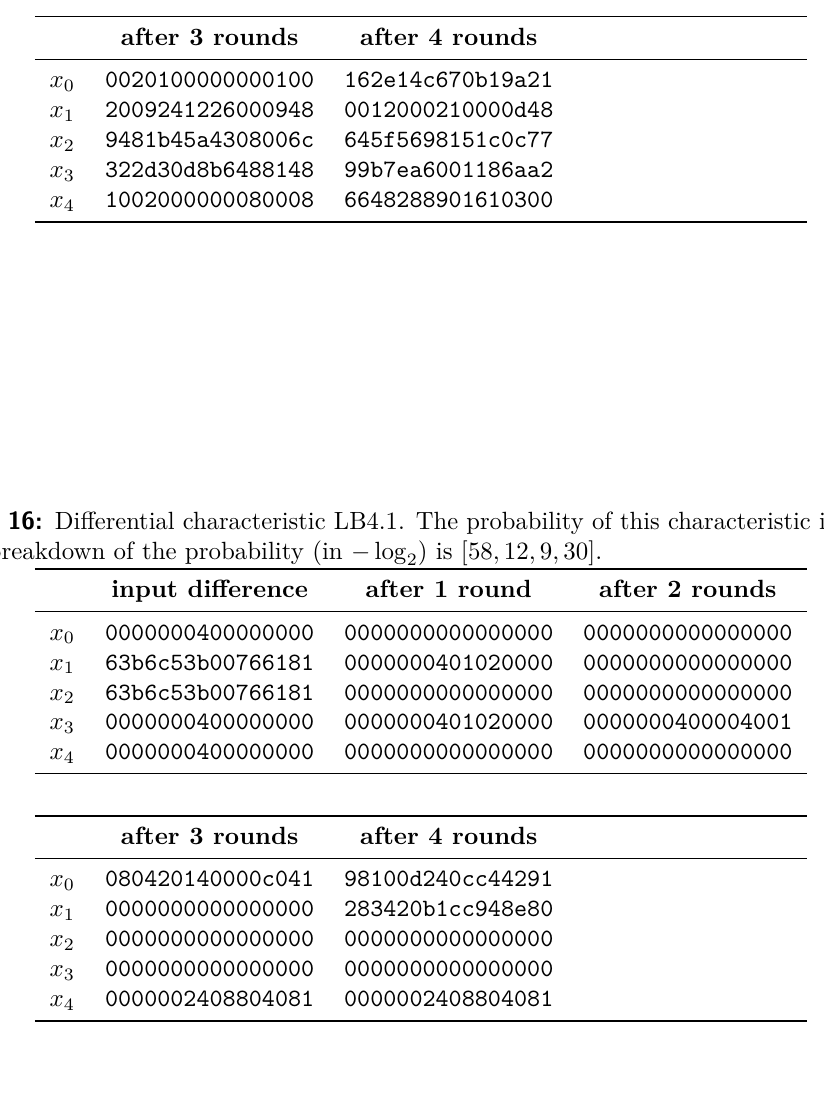
Table 15: Differential characteristic LB4. The probability of this characteristic is 2 − 147 . The breakdown of the probability (in − log